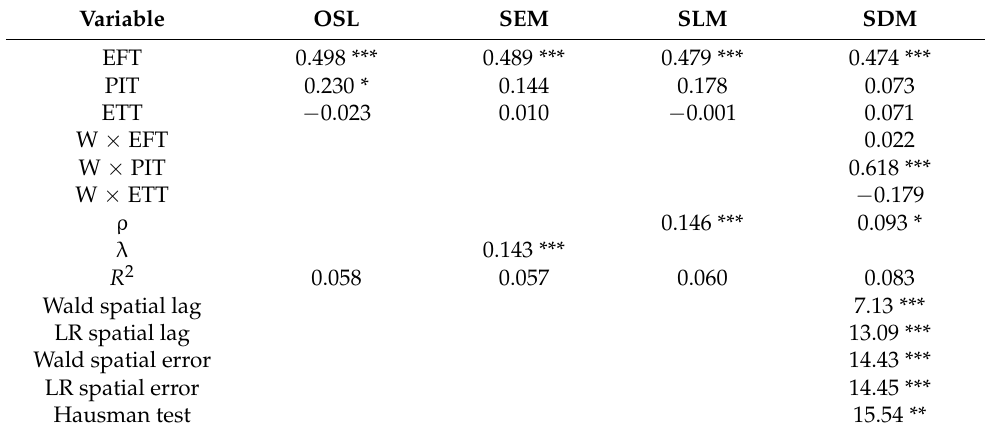
Table 5. Regression analysis results of the effect of GTI on EWP.